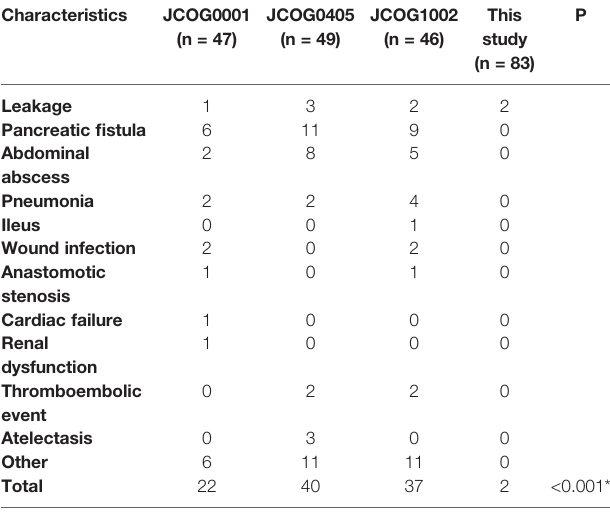
TABLE 4 | Surgical complications in all operated